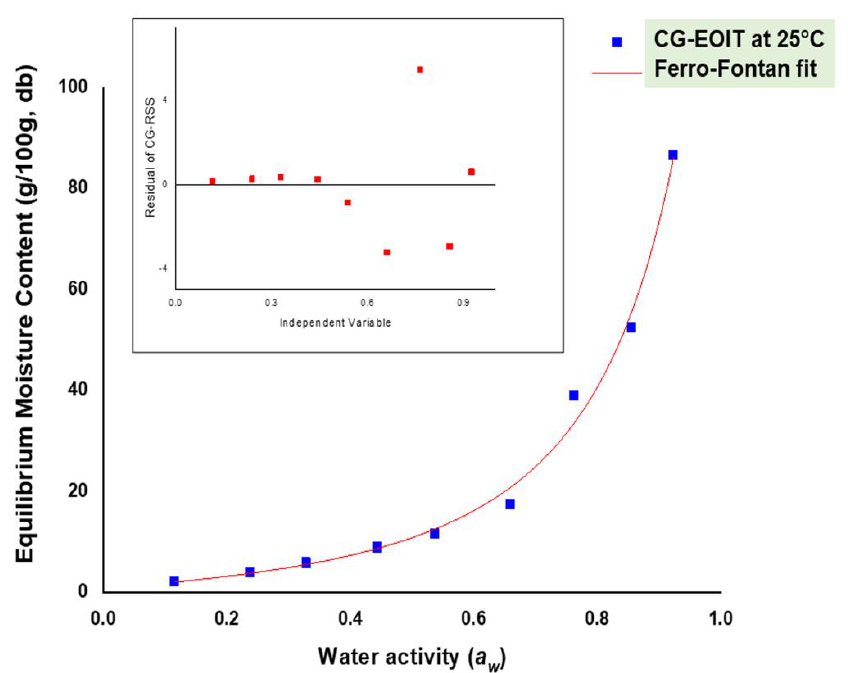
R 2 = Coefficient of determination, P = Percent mean deviation error, RMS% = Root mean square error percent (values highlighted in bold are the best-fit models).